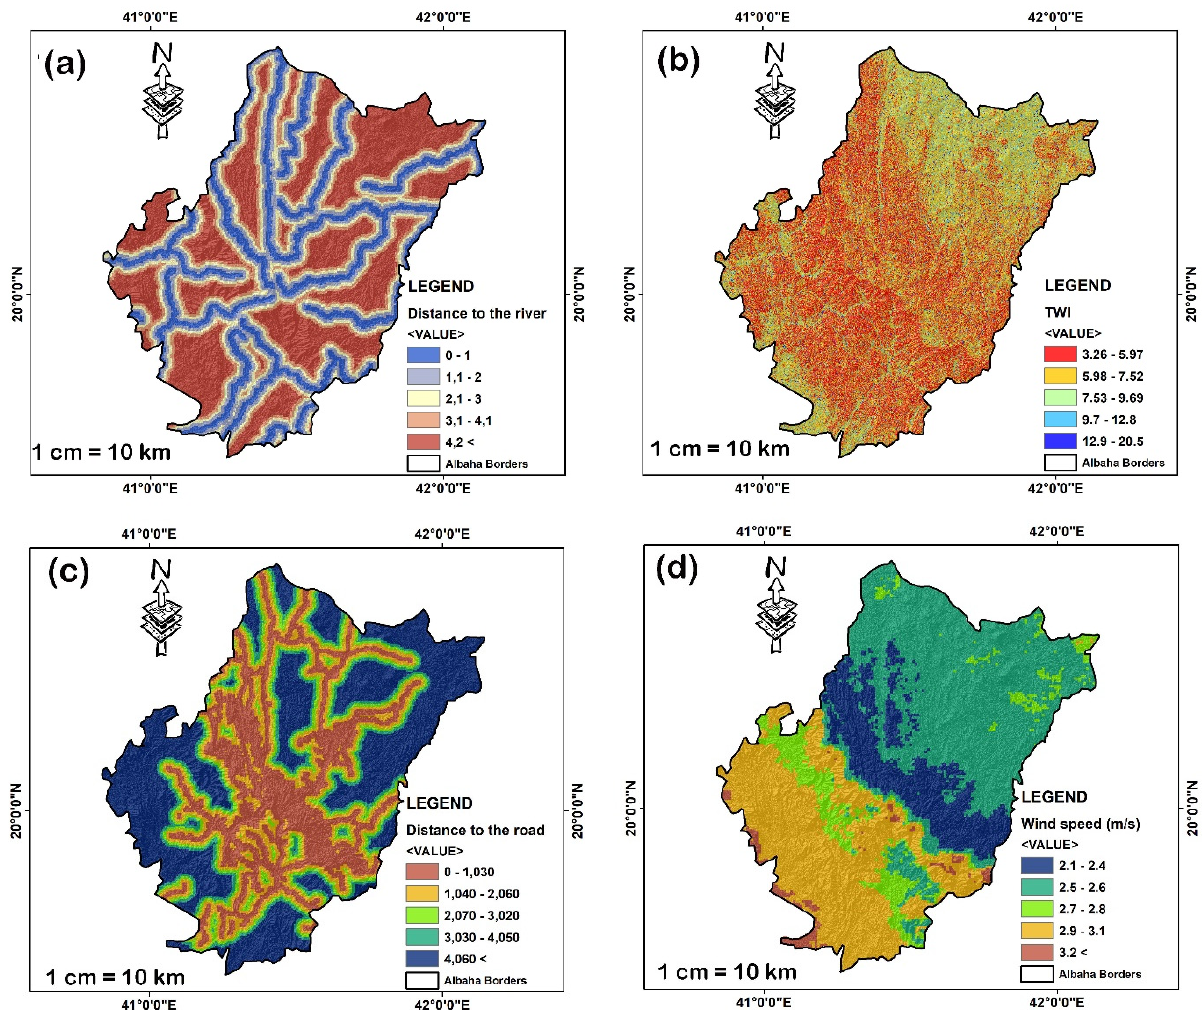
Figure 3. Representation of ( a ) distance to the water lines, ( b ) topographic wetness index, ( c ) distance to the road, ( d ) wind speed.